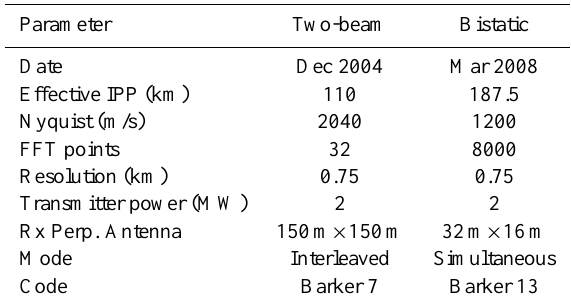
Table 1. Parameters for perpendicular and off-perpendicular 150- km experiments at